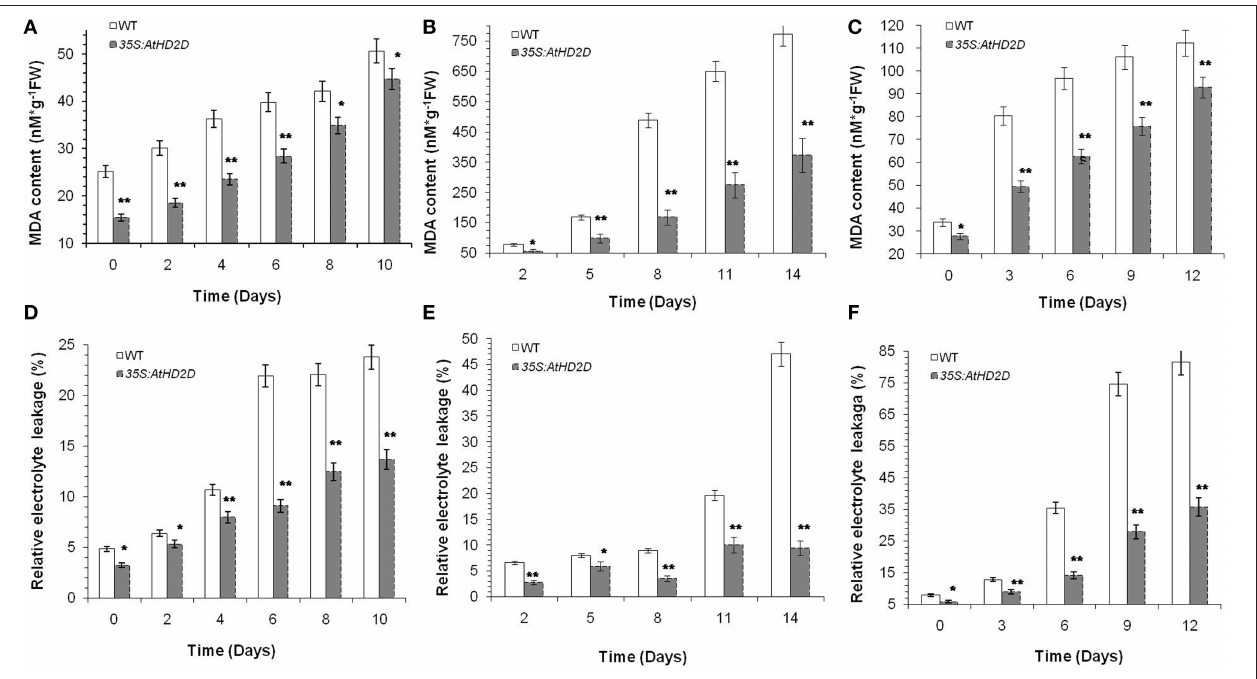
FIGURE 7 | Malonaldehyde (MDA) and electrolyte leakage levels in WT and 35S:AtHD2D transgenic plants under abiotic stresses. The error bars represent the SD . The data are presented as the mean ± standard deviation of the mean ( SD ) and were tested for significant difference using Student’s t -test ( * p < 0.05 , ** p < 0.01 ). (A) MDA level under cold stress condition. (B) MDA level under drought stress condition. (C) MDA level under salt stress condition. (D) Electrolyte leakage level under cold stress. (E) Electrolyte leakage level under drought stress. (F) Electrolyte leakage level under salt